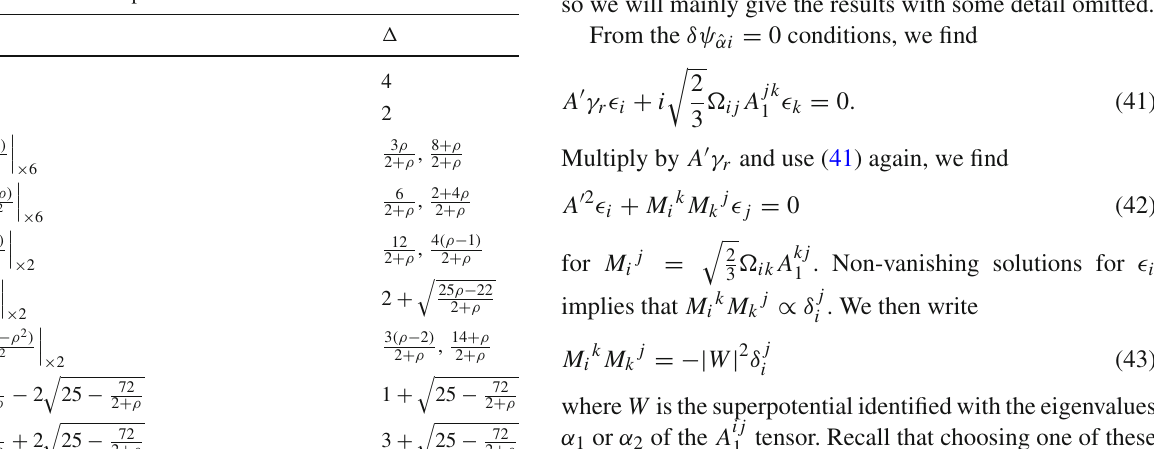
Table 3 Scalar masses at the N = 2 supersymmetric AdS 5 critical point III with SO ( 2 ) diag × SO ( 3 ) symmetry and the corresponding dimensions of the dual operators